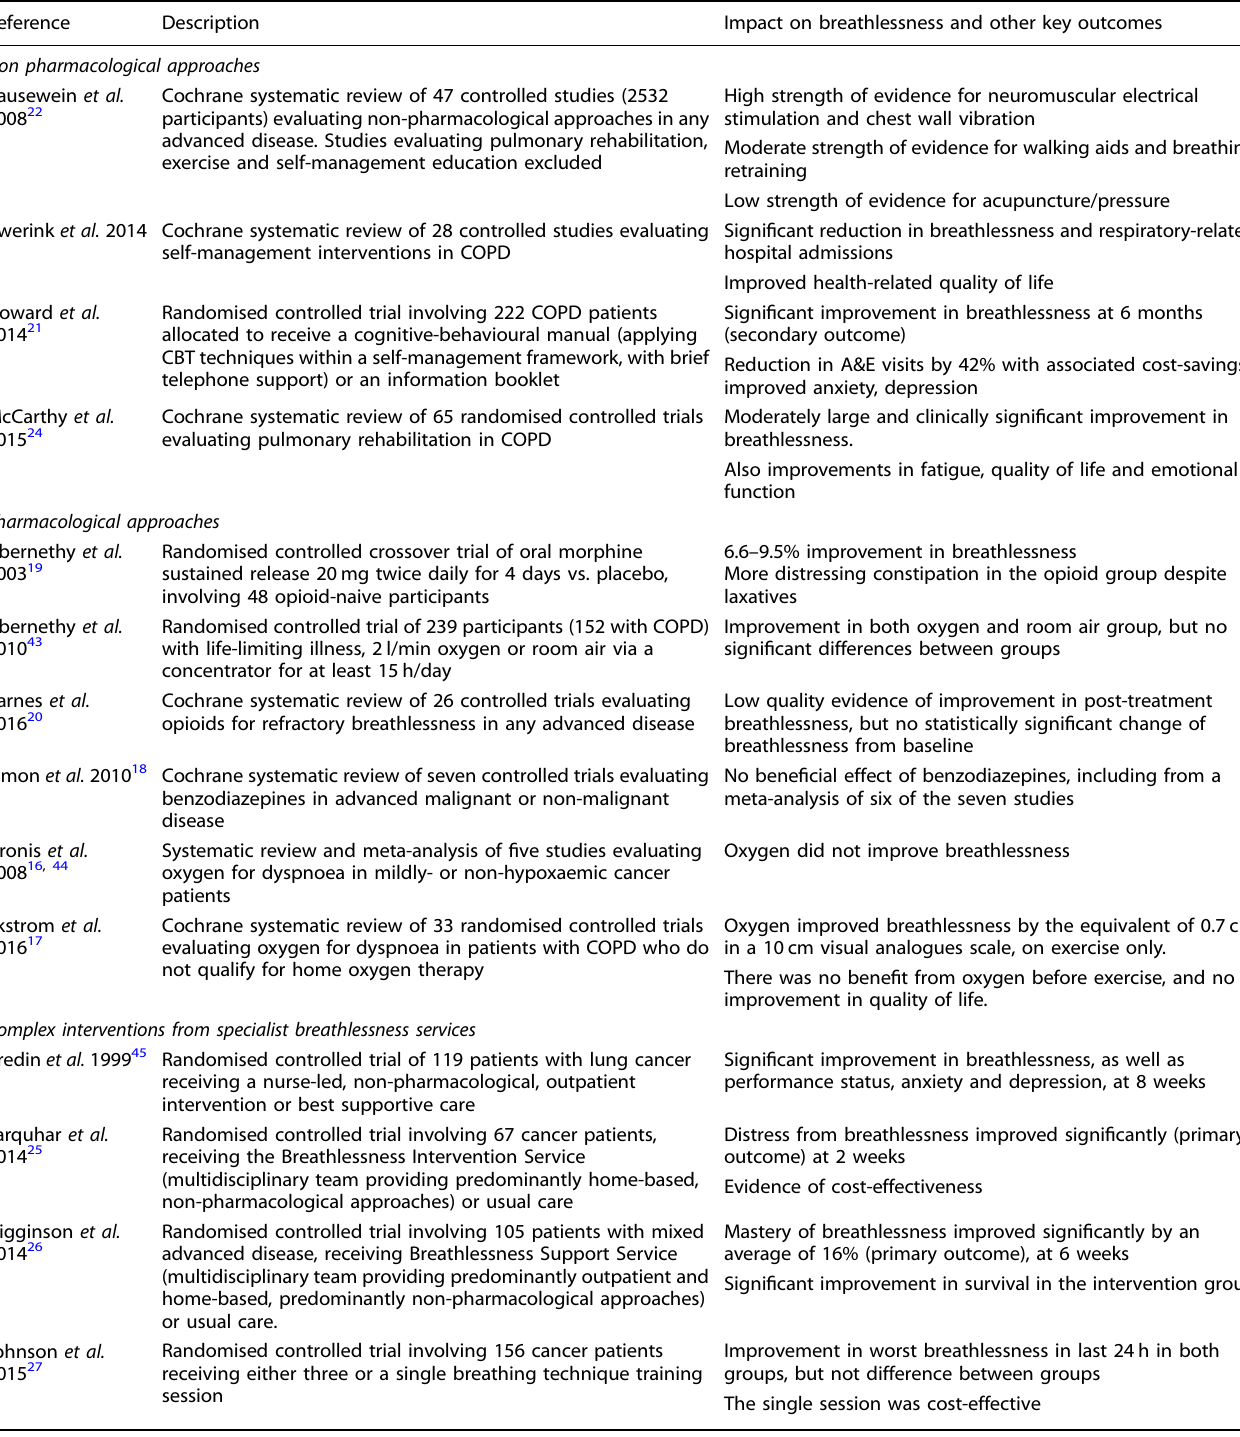
Table 1. Summary of key evidence for approaches to the management of breathlessness in advanced disease